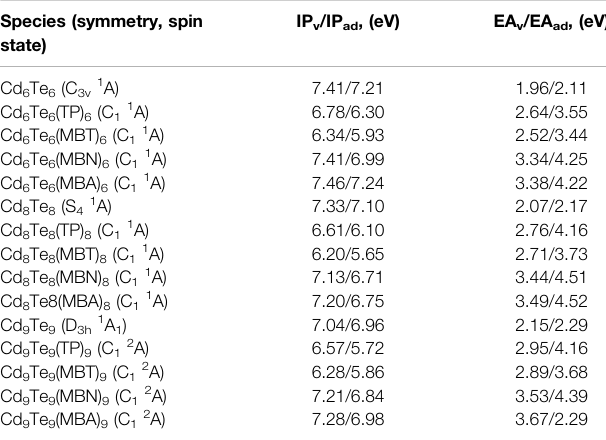
TABLE 3 | Calculated vertical and adiabatic IPs and EAs (eV) in the gas phase of bare Cd n Te n ( n (cid:1) 6, 8, and 9) QDs and capped Cd n Te n L n QDs (where L (cid:1) TP, MBT, MBN, and MBA) using B3LYP/Lanl2dz level of theory. Species (symmetry, spin